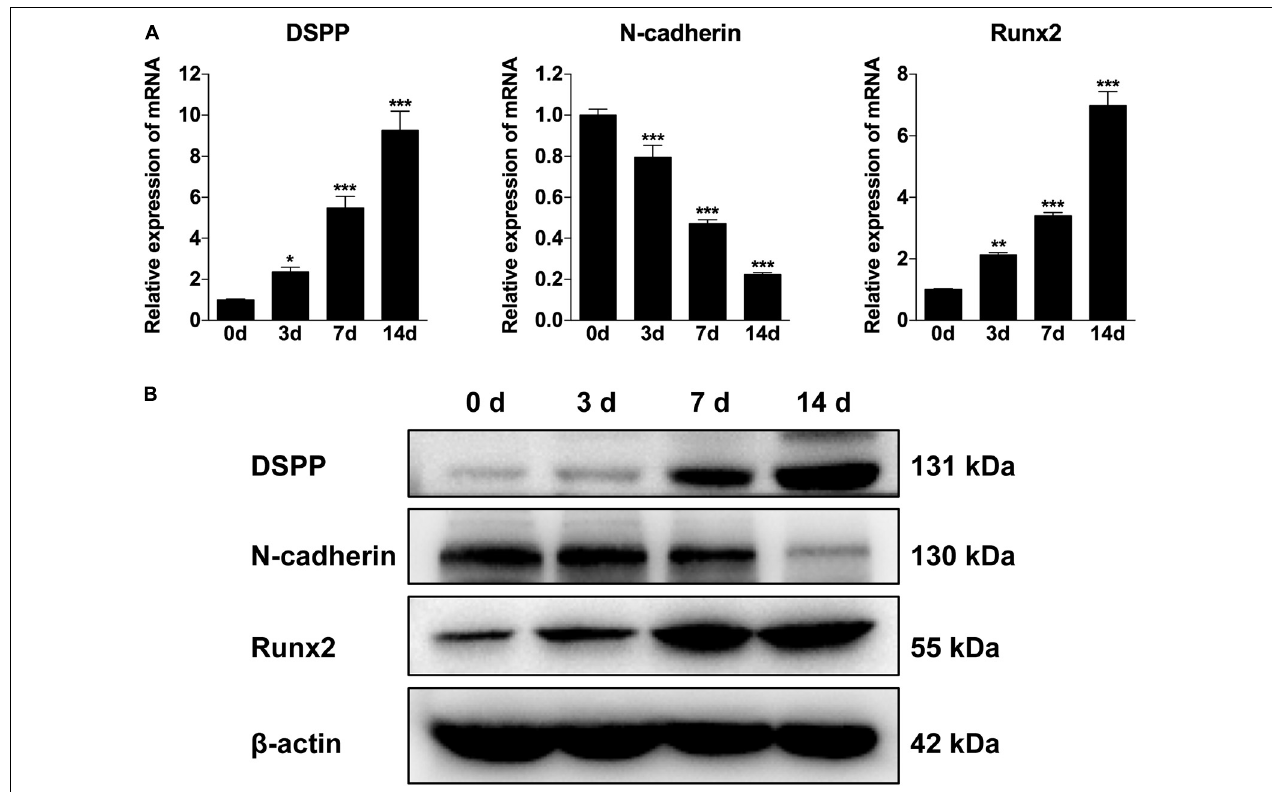
FIGURE 1 | The expression of N-cadherin was decreased during odontogenic differentiation of dental pulp stem cells (DPSCs). DPSCs were cultured in odontogenic medium for 3, 7, and 14 days, and then the expression pattern of N-cadherin and odontogenic markers (dentin sialophosphoprotein, DSPP, and runt-related transcription factor 2, Runx2) were examined by qPCR (A) and western blot (B) analysis. Data are presented as the mean ± SEM of three independent experiments. * P < 0.05, ** P < 0.01, *** P <